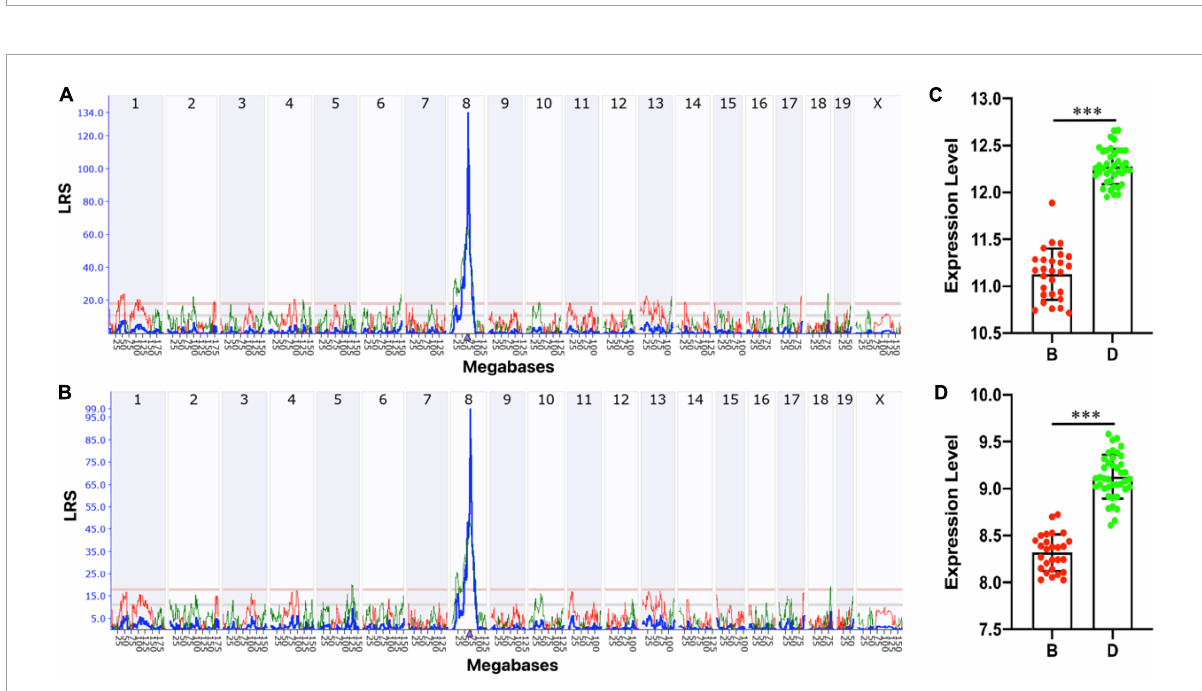
FIGURE4 Expression quantitative trait locus (eQTL) mapping for Lpl . Manhattan plots showing the genome-wide regulating locus for probe 1415904_at (A) and 1431056_a_at (B) in the BXD hippocampus. The x -axis denotes a position on the mouse genome in megabases (Mb) and the y -axis indicates the LRS score. This analysis was done on GeneNetwork (https://www.genenetwork.org/) with the “interval mapping” method. The genome-wide suggestive and significant thresholds were determined with 1,000 permutation tests. Bar plots showing the mRNA level of probe 1415904_at (C) and 1431056_a_at (D) between (B,D) alleles at 69.676 Mb on Chr 8 (rs48549917). The values are log2 transformed and *** p <